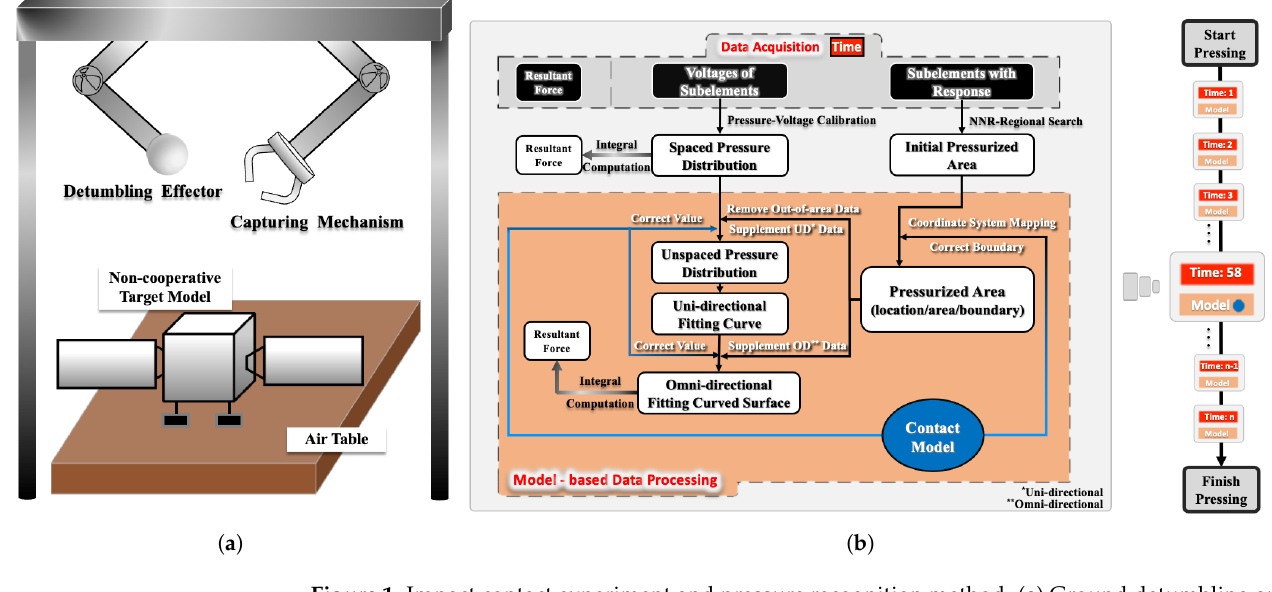
Figure 1. Impact contact experiment and pressure recognition method. ( a ) Ground detumbling and capturing experiment for large non-cooperative target. ( b ) Impact Pressure Distribution Recognition (IPDR)